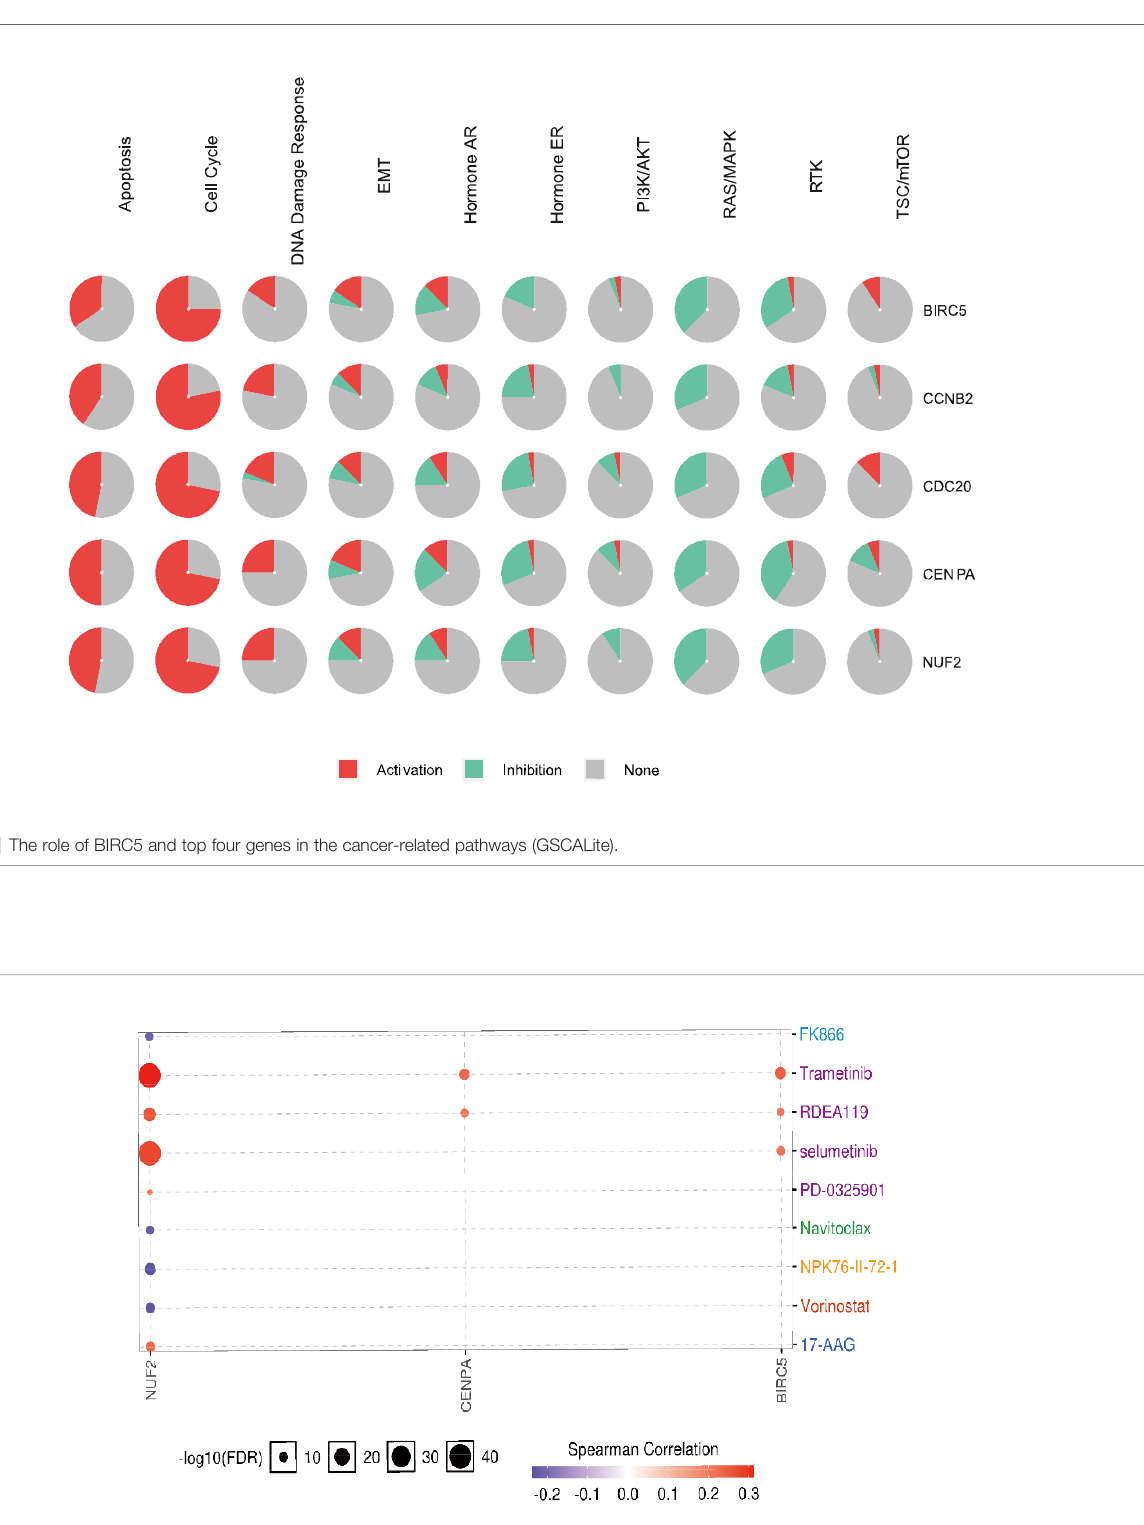
Frontiers in Oncology |